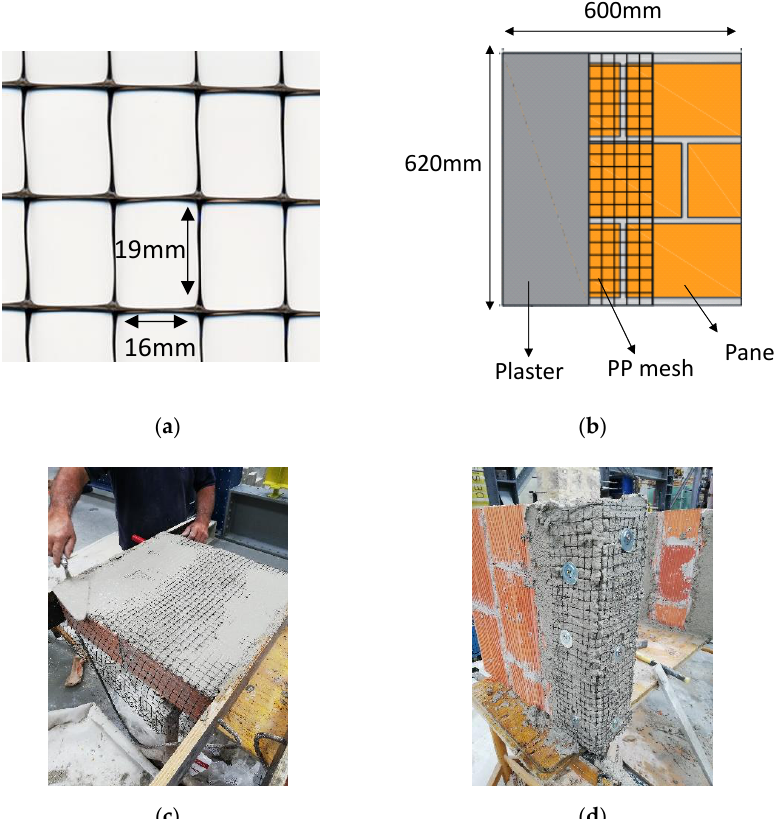
Figure 1. SWM group: ( a ) detail of the PP (weak) textile mesh size; ( b ) layout of the strengthening strategy adopted for SWM specimens; ( c ) strengthening of the MIW (front view of the specimen); and ( d ) strengthening of the MIW (top and backside of the specimen).